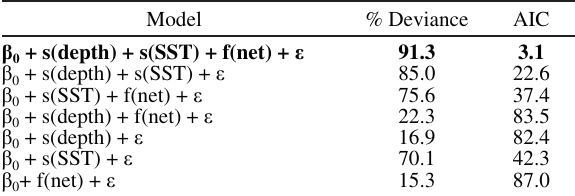
Table 2. – GAM for P. kerathurus catch rates (biomass index). β is the intercept, s(depth) is a smoothing effect associated with the depth (m), s(SST) is a smoothing effect associated with sea surface temperature, f(net) is the factor net type (STN, TGN20, TGN25), and ε is the error term. AIC, Akaike information criterion; % Devi- ance, deviance explained. The best model is highlighted in bold.